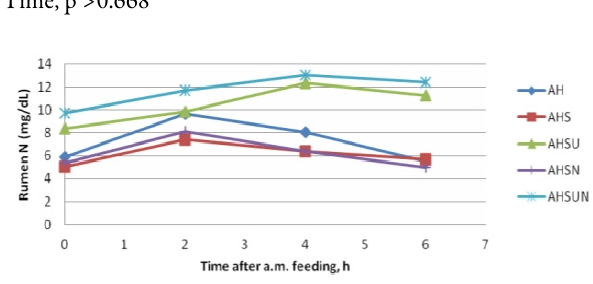
Fig 2. Effects sesame stover treated with NaOH or urea pluss alfalfa hay on ruminal ammonia concentration in sheep. Effect of Treatment x Time,